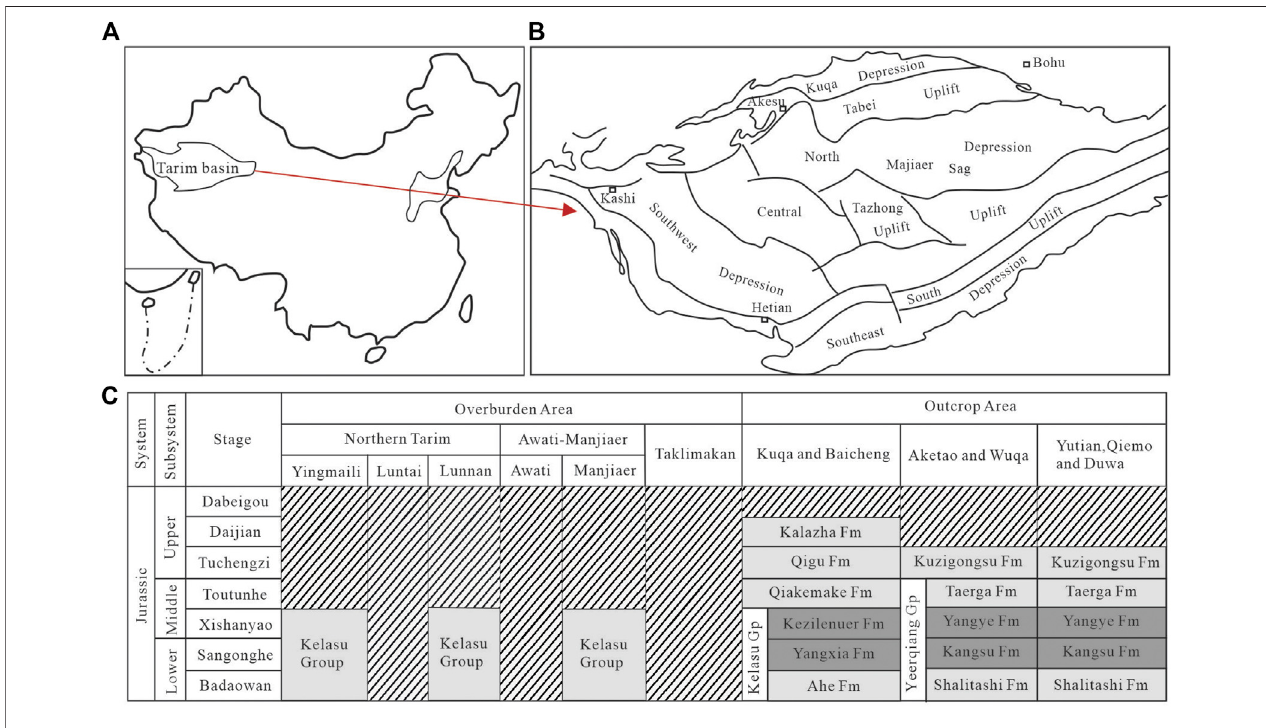
FIGURE 1 | (A) The location of the Tarim Basin in China. (B) Distribution map of structural units in the Tarim Basin. (C) Stratigraphy for Jurassic strata in the Tarim Basin: dark gray units are predominantly shale and light gray units are predominantly sandstone (the Jurassic stratigraphy is according to Wang et al.,